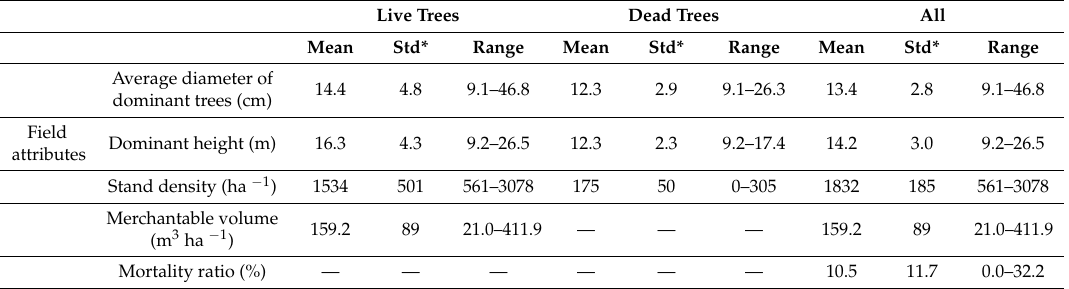
Table 1. Summary of the 61 field plot measurements for the Montmorency Forest study